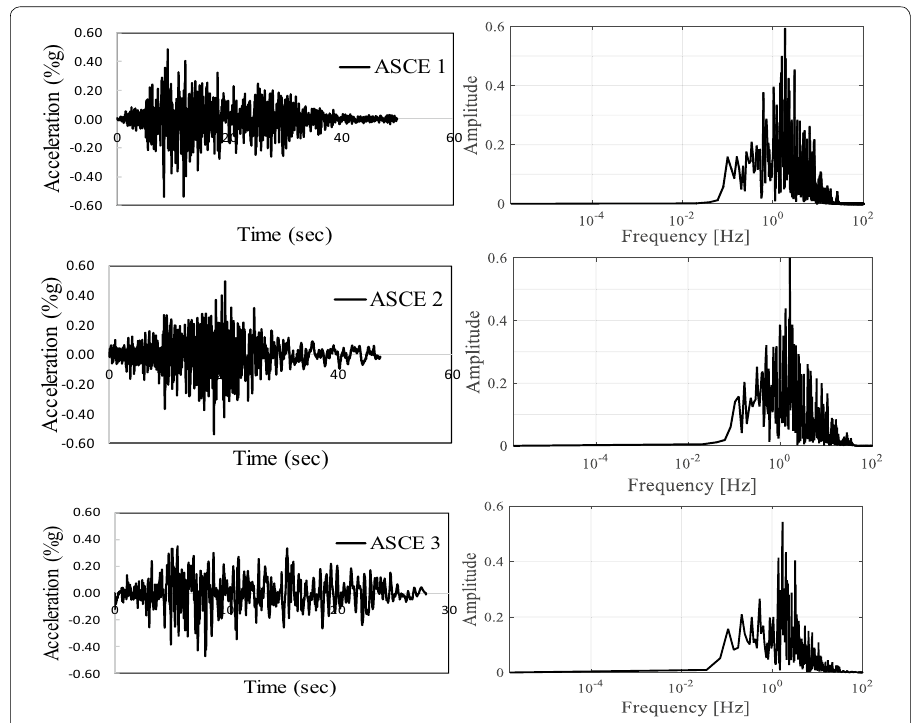
Fig. 6 Acceleration time histories with their Fourier spectrums